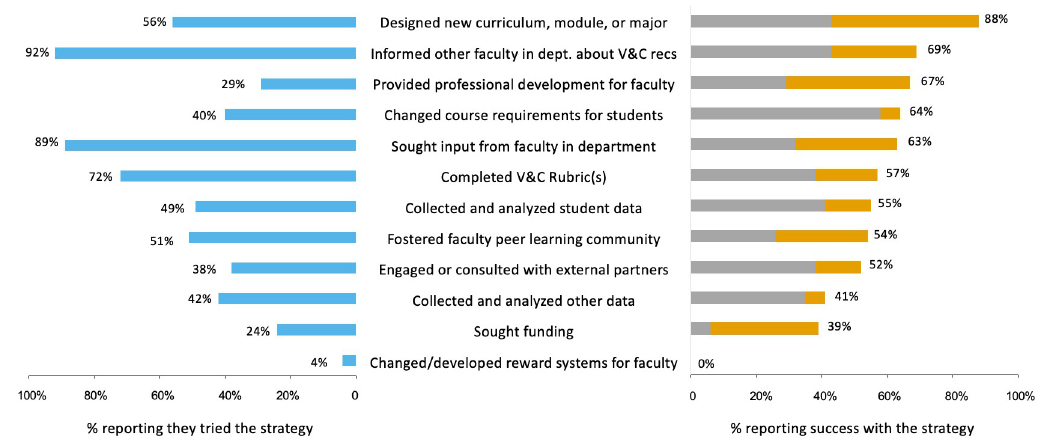
Fig 8. Change strategies tried by participants and reported success of use. Participants (n = 79) were given a list of transformation strategies and asked if they had tried the strategy (left panel) and if they agreed that the strategy was somewhat successful or very successful in helping the team achieve its desired outcome (right panel, grey and orange